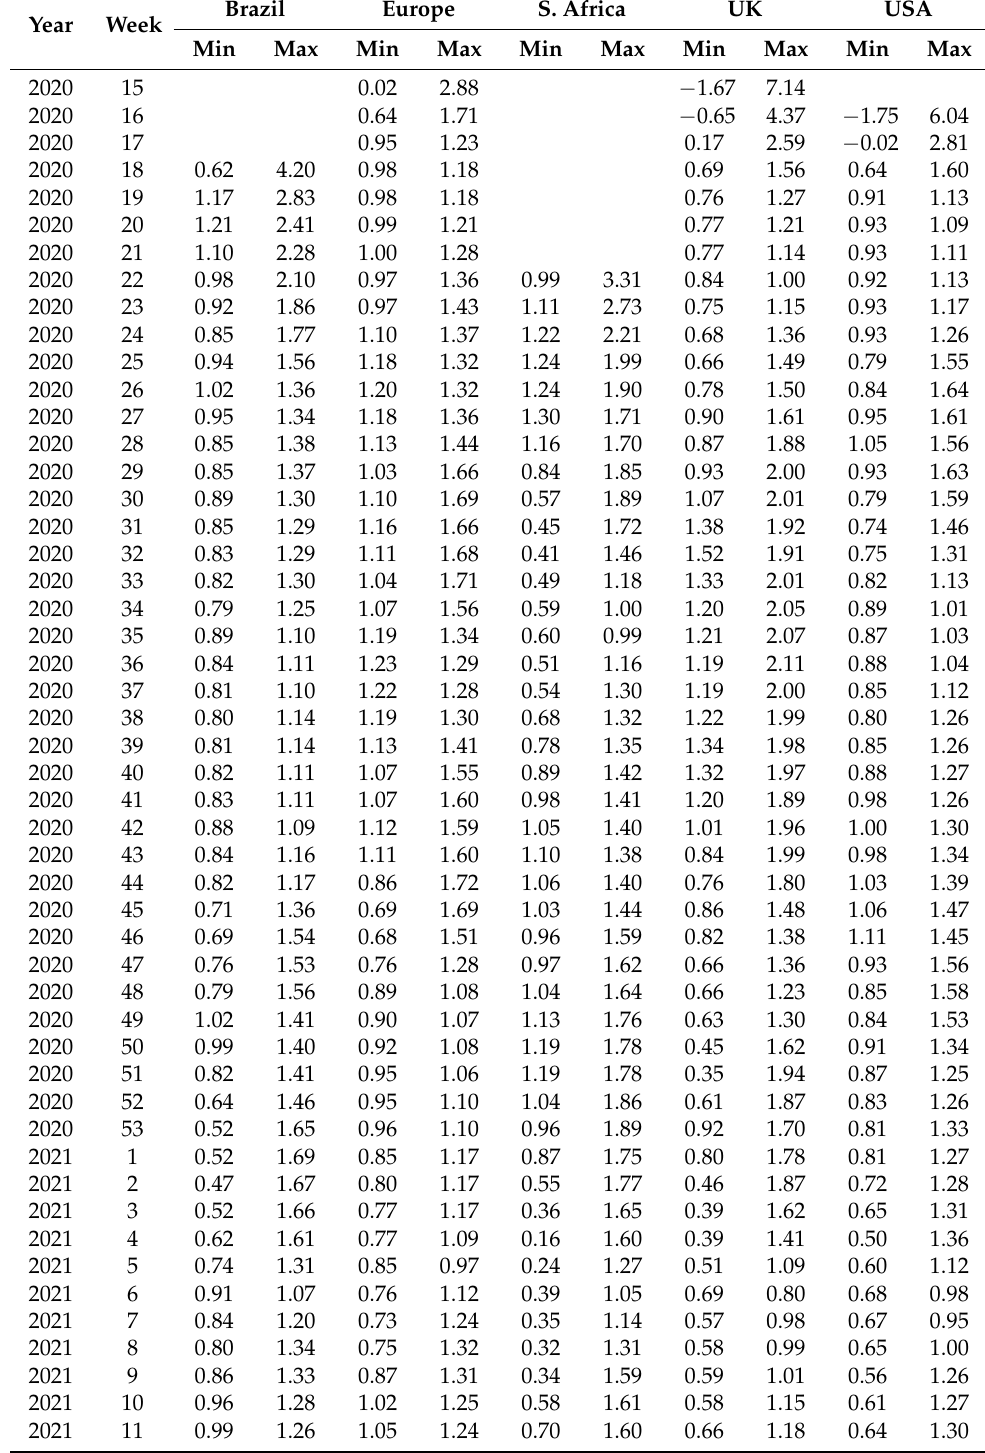
Table 3. 95% confidence intervals for the empirical